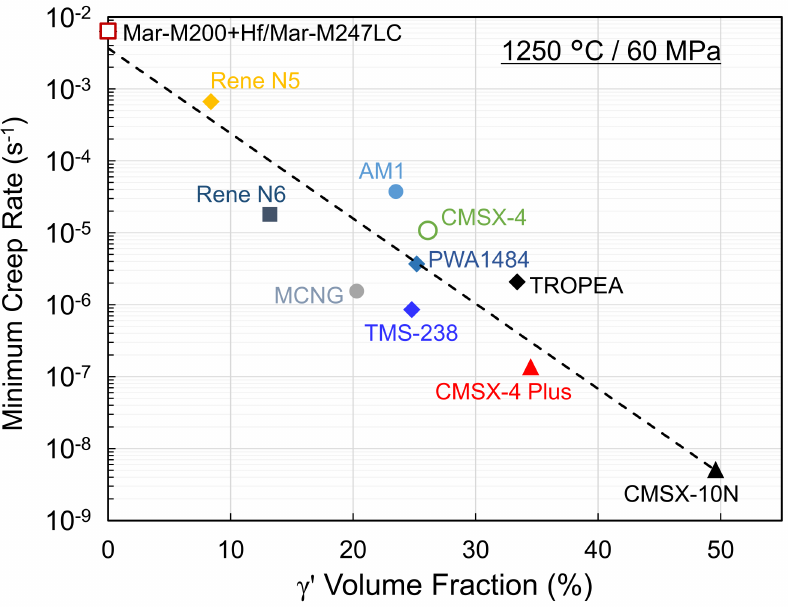
Figure 11. Minimum creep rate as a function of γ (cid:48) volume fraction of SX superalloys after creep tests at 1250 ◦ C/60